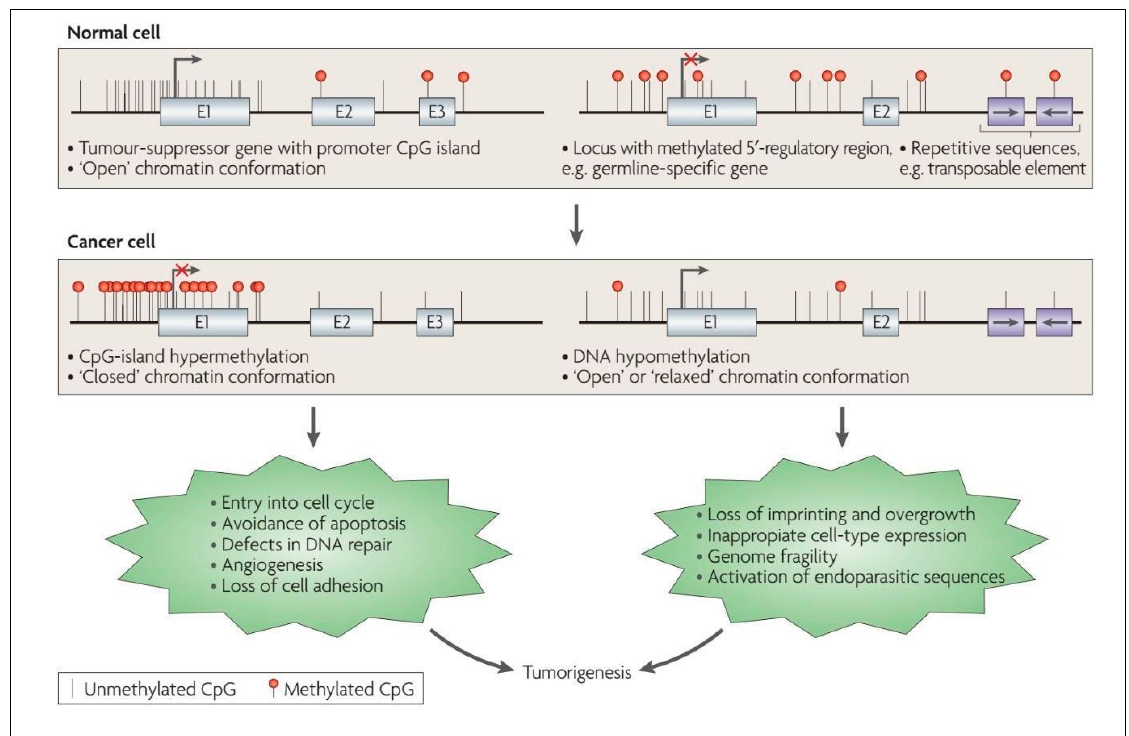
Figure 2. Altered DNA methylation and its downstream impact in the cancer cell. Reproduced with permission from [28]. The process of DNA methylation is carried out by DNA methyltransferases (DNMT),